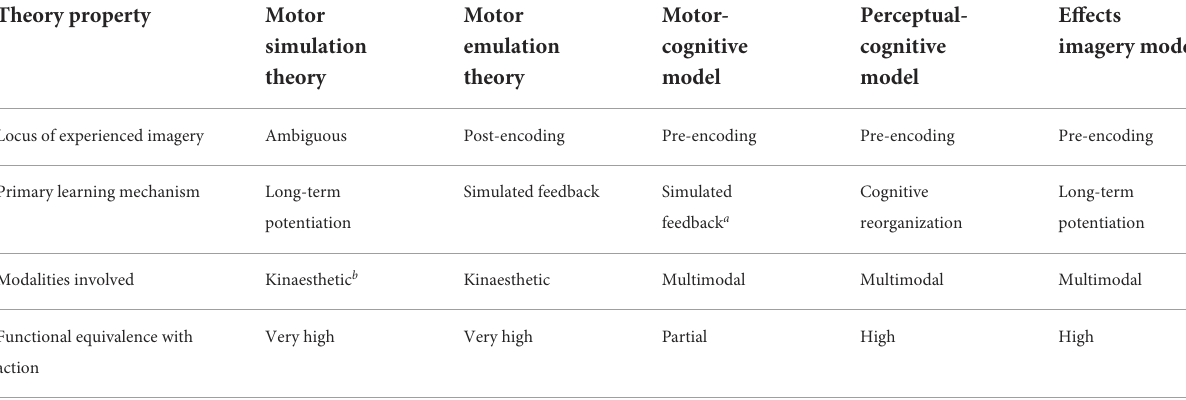
TABLE 1 A summary of the properties of different theories of motor